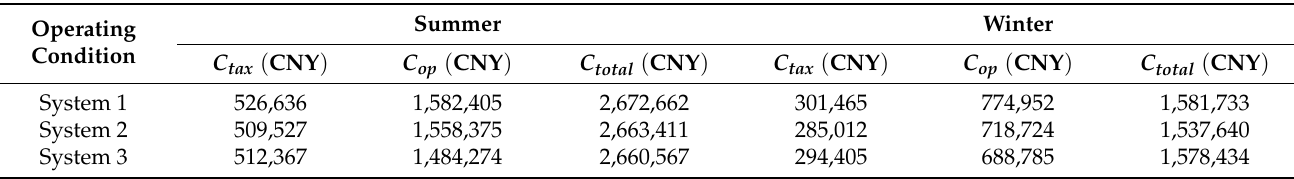
Table 9. Costs of three systems under winter and summer operating